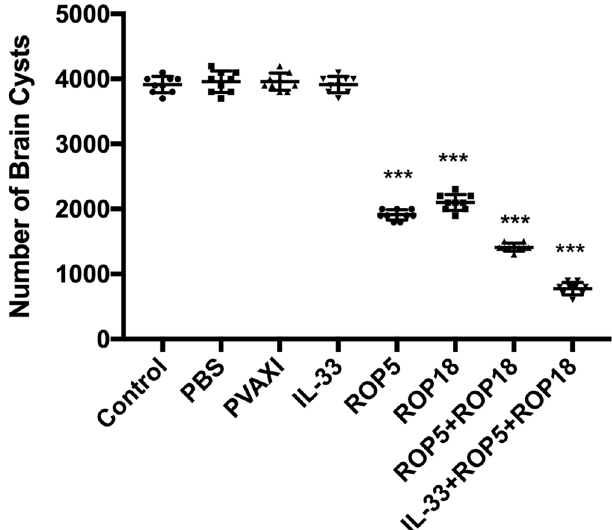
Figure 5. Survival curves of Kunming mice after challenge of T. gondii RH strain. The mice (10 per group) in all groups were challenged with 1 (cid:2) 10 3 tachyzoites of the virulent T. gondii RH strain intraperitoneally. Three control groups (PBS, pVAX I and blank control) had 0% survival at day 7. Immunized groups had prolonged survival time of